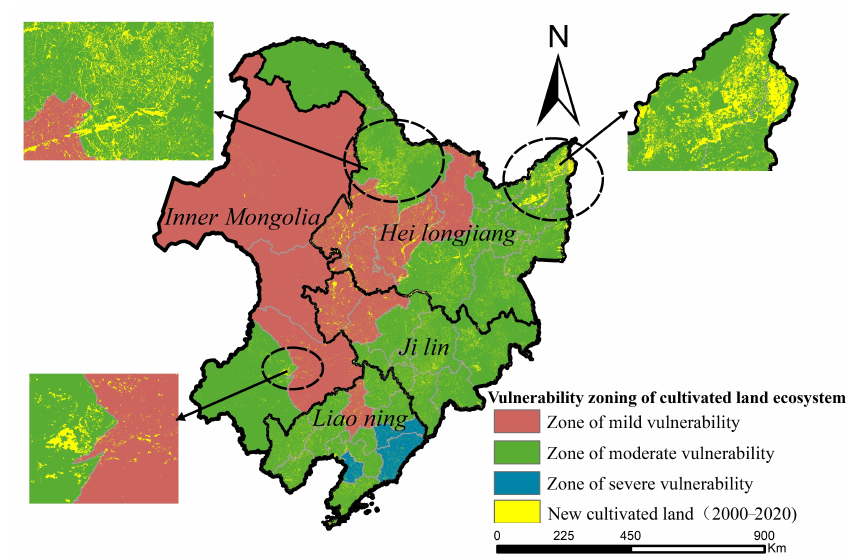
Figure 9. Spatial pattern of ecosystem vulnerability in Northeast China.